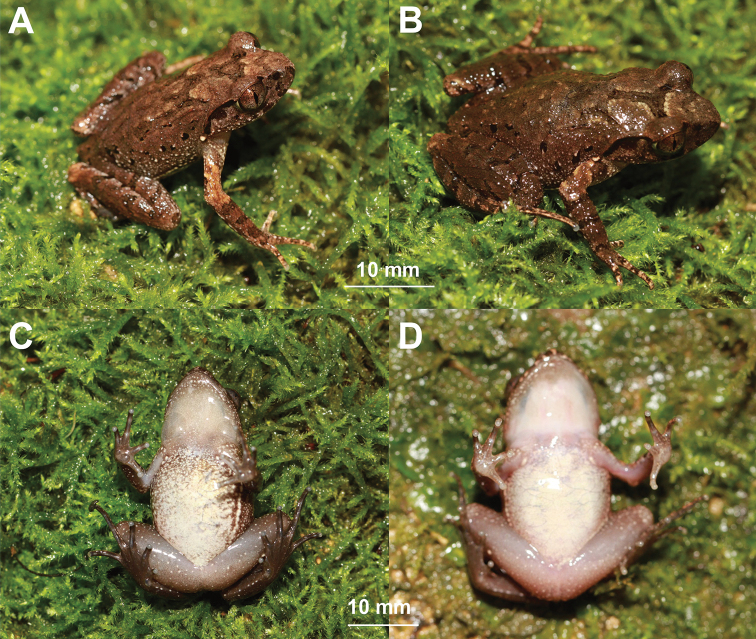
Colour variation in Leptobrachella
chishuiensis sp. nov. A dorsal view of the male specimen CIBCS20190518042 B dorsal view of the female specimen CIBCS20190518046 C ventral view of the female specimen CIBCS20190518046 D ventral view of the female specimen CIBCS20190518049.